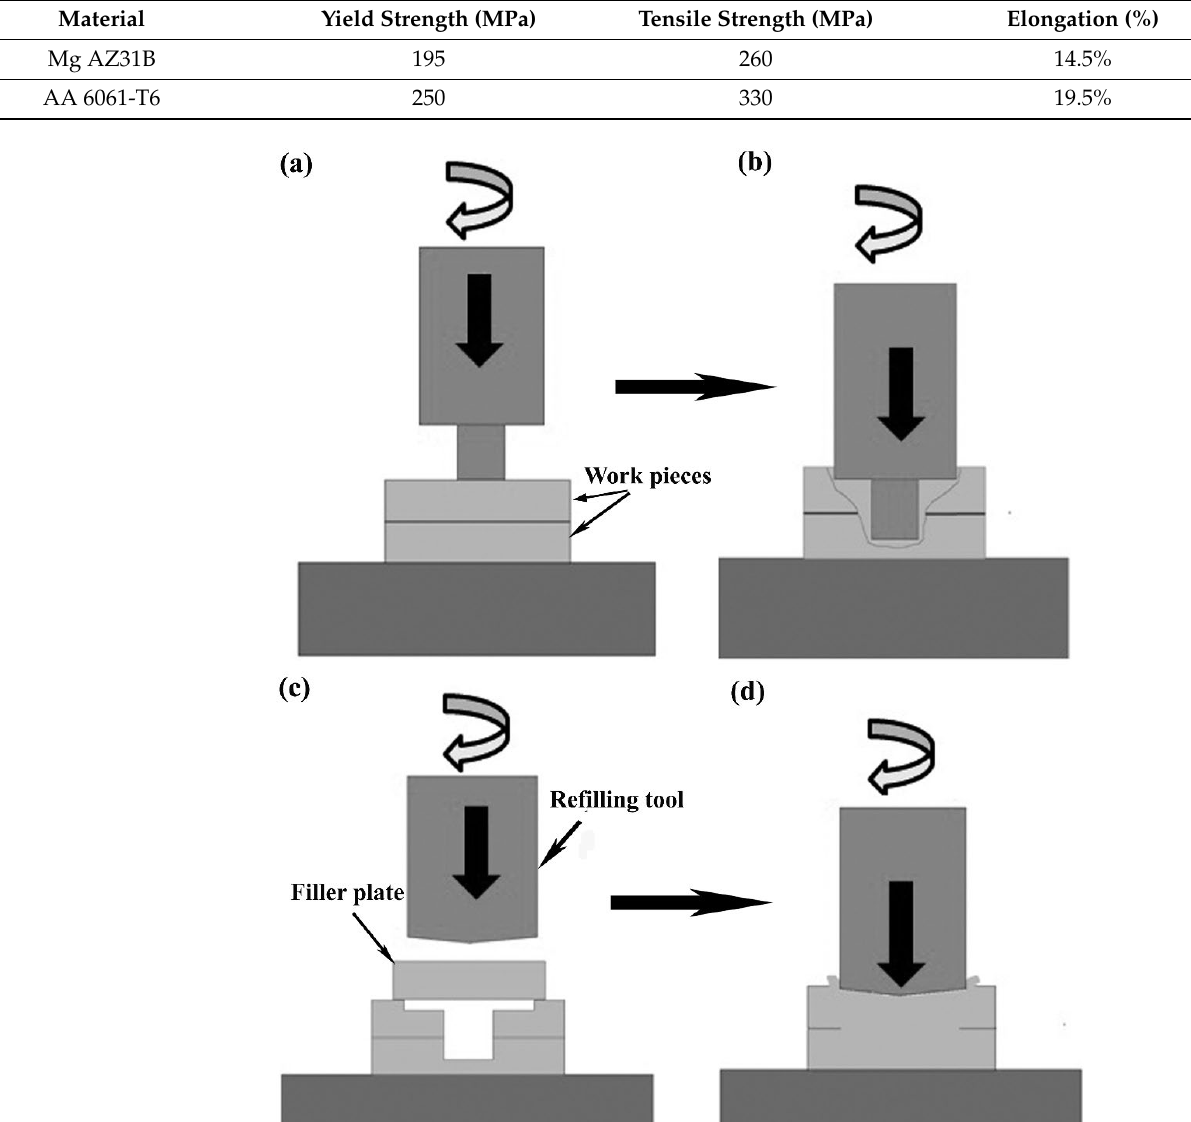
Table 2. Tensile properties of AZ31B magnesium alloy and AA6061-T6 aluminum alloy.